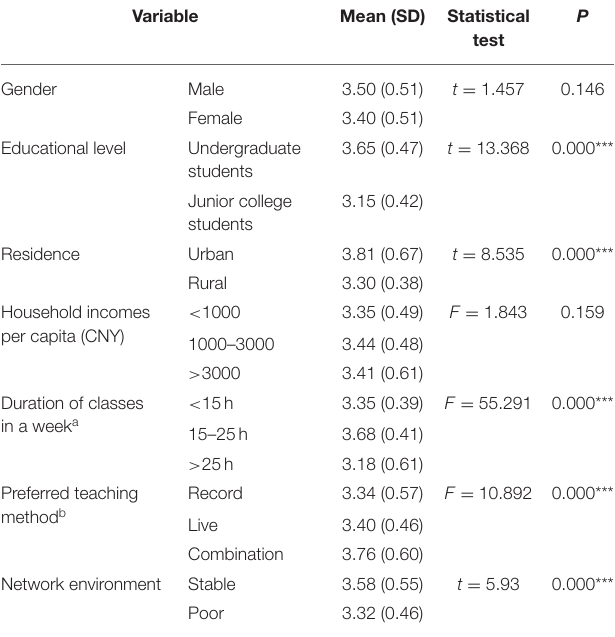
TABLE 2 | Undergraduates’ Learning Adaptability Questionnaire (ULAQ) scores among nursing students with different sociodemographic characteristic ( N = 585).